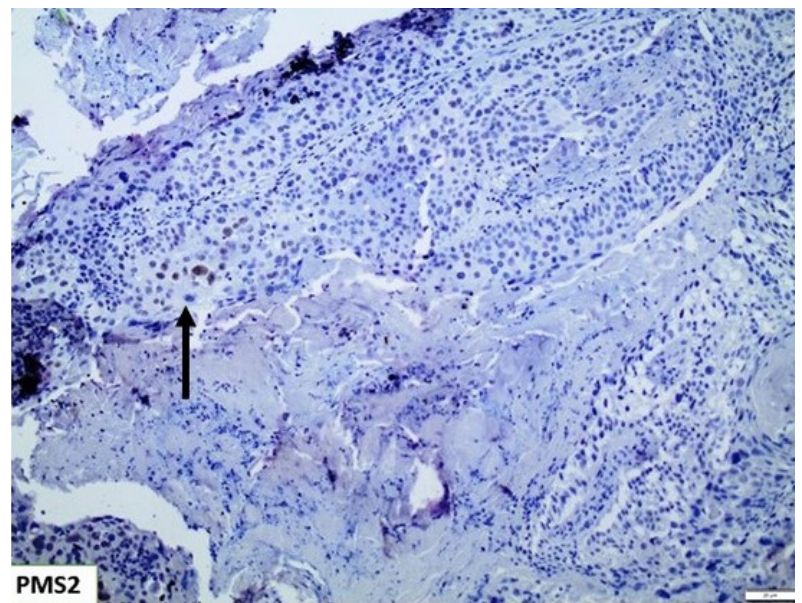
Figure 6. Cases with low PMS2 expression levels are characterized by longer overall survival (OS) and disease ‐ free survival (DFS); however, this correlation is not statistically significant ( p ‐ values 0.071 and 0.06, respectively). Figure 5. PMS2 showing extensive loss of expression, with only few nuclei retaining its expression ( Arrow) (×100).